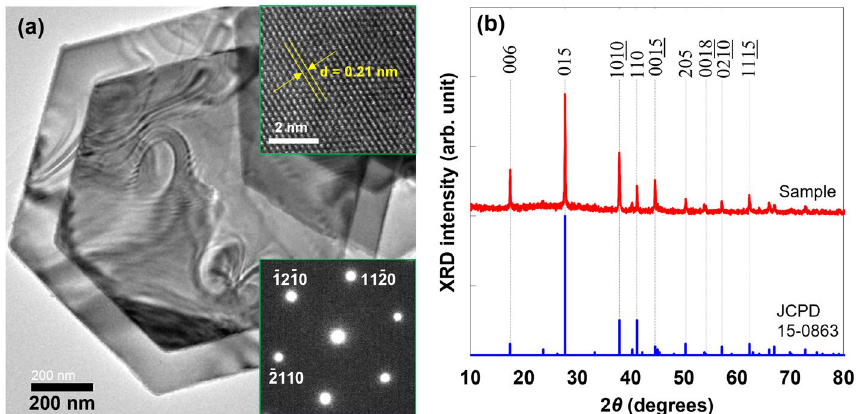
Figure 2. ( a ) TEM image of Bi 2 Te 3 nanoplates prepared by solvothermal synthesis. The insets show the HRTEM image and SAED pattern. ( b ) X-ray diffraction patterns of the Bi 2 Te 3